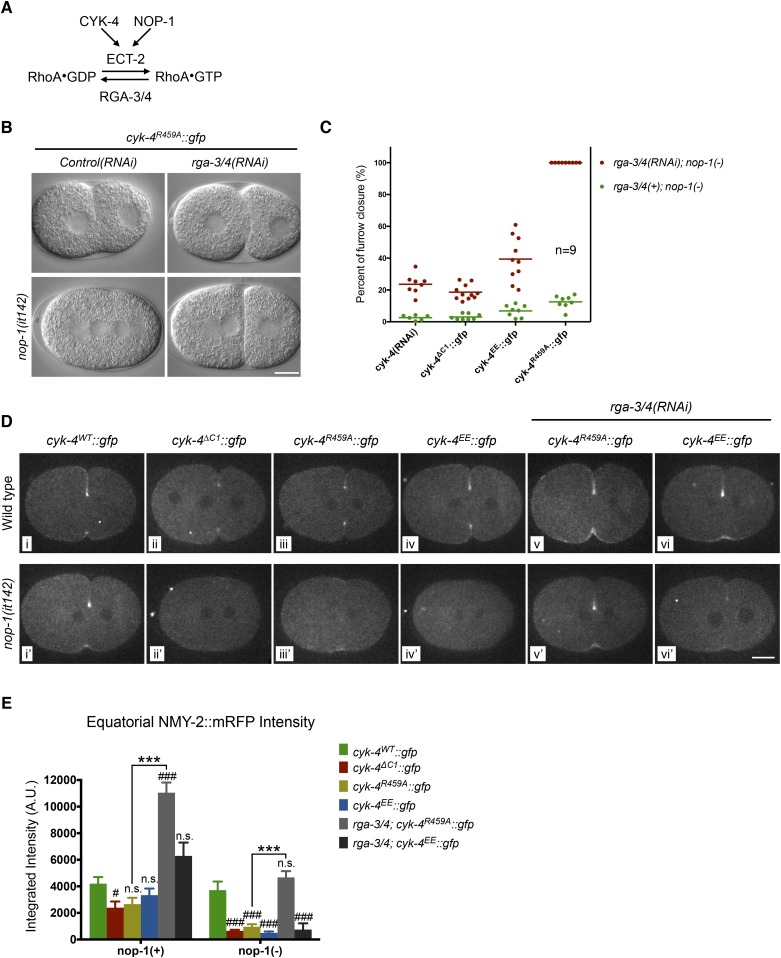
Depletion of RGA-3/4 rescues cytokinesis in CYK-4R459A embryos.(A) Schematic depiction of the known regulators of RhoA. (B) Representative embryos demonstrating the effect of RGA-3/4 depletion on cytokinesis in CYK-4R459A embryos both in the presence and absence of NOP-1 function. (C) Depletion of RGA-3/4 rescues cytokinesis specifically in CYK-4R459A embryos. CYK-4∆C1, CYK-4EE, CYK-4R459A where expressed in nop-1(it142) embryos and the extent of furrow closure measured either in the presence (green) or the absence (red) of RGA-3/4. (D) Accumulation of the RhoA effector NMY-2 (tagged with RFP) in embryos of the indicated genotypes. Embryos are shown at ∼50% (or maximal) ingression. Note the reduction of cortical myosin accumulation in CYK-4R459A, CYK-4EE, CYK-4∆C1 embryos as compared to CYK-4WT (i–iv). The severity of this reduction is enhanced by inactivation of NOP-1 (i′–iv′). Depletion of RGA-3/4 restores myosin accumulation in CYK-4R459A and CYK-4EE embryos (v, vi), even in embryos defective in NOP-1 function (v′, vi′). (E) Quantification of total NMY-2::mRFP accumulation in the furrow region over the course of cytokinesis in embryos of the indicated genotypes. Error bars, s.e.m.; n.s. (not significant); #p < 0.05; ###p < 0.001 refers to significance relative to wild-type in nop-1(+) and nop-1(it142), respectively by one way ANOVA followed by Tukey multiple comparison. ***p < 0.001 for the indicated comparison.